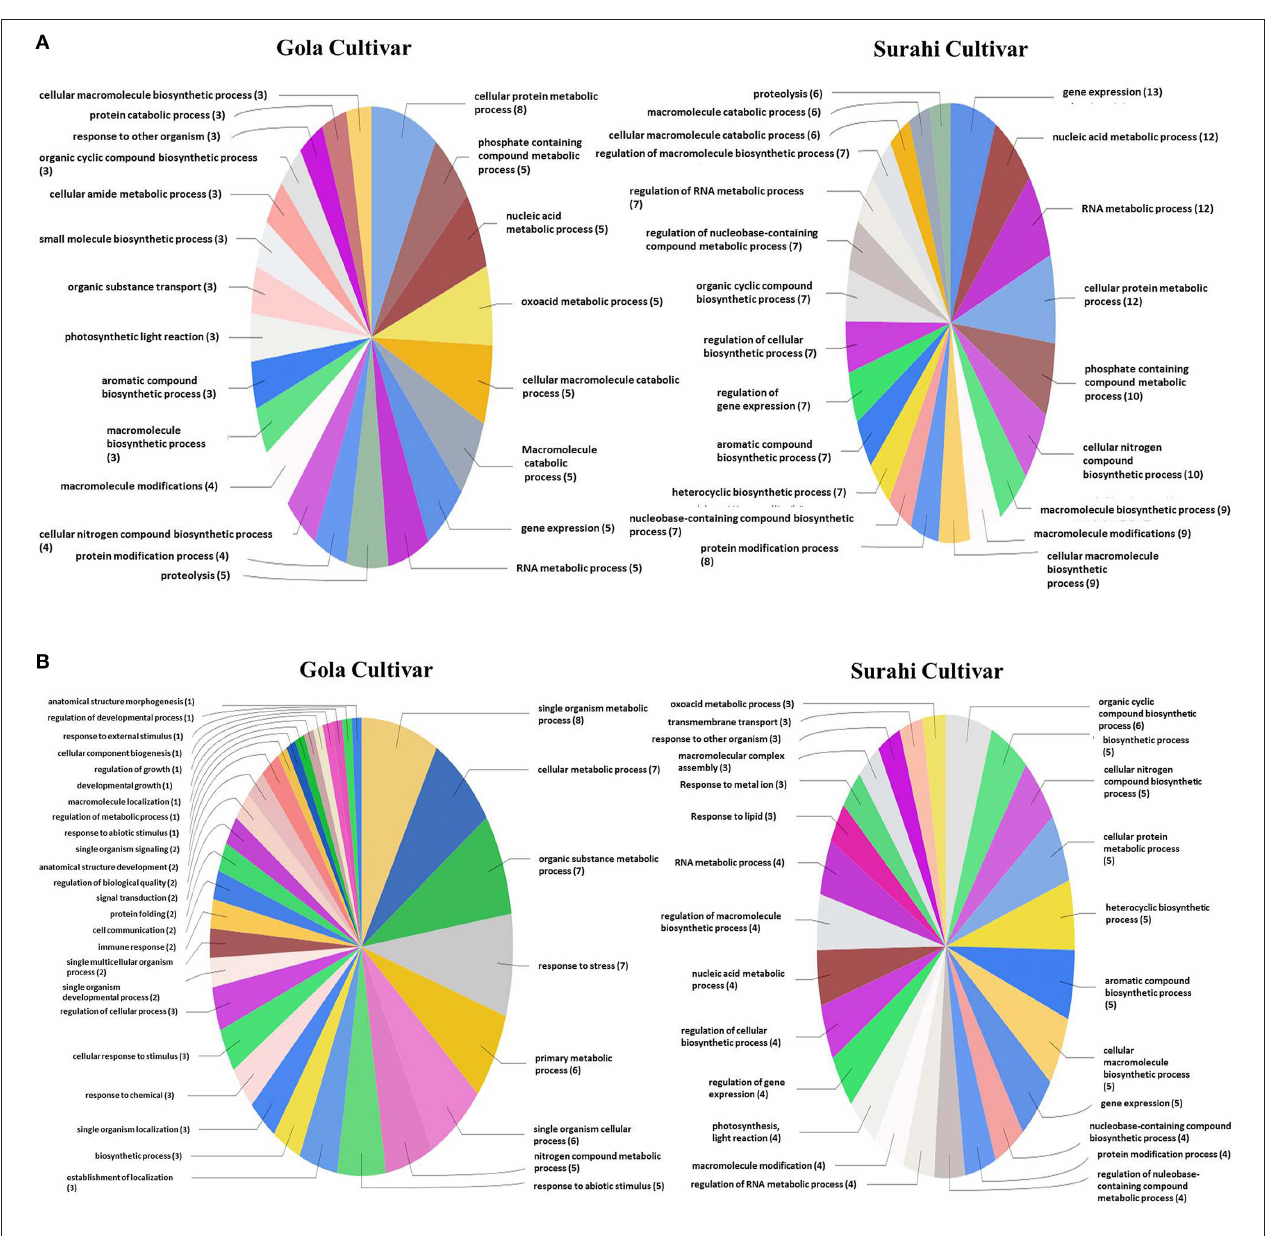
FIGURE 4 | Functional annotation of the upregulated (A) and downregulated (B) ESTs in biological process of guava under drought stress.